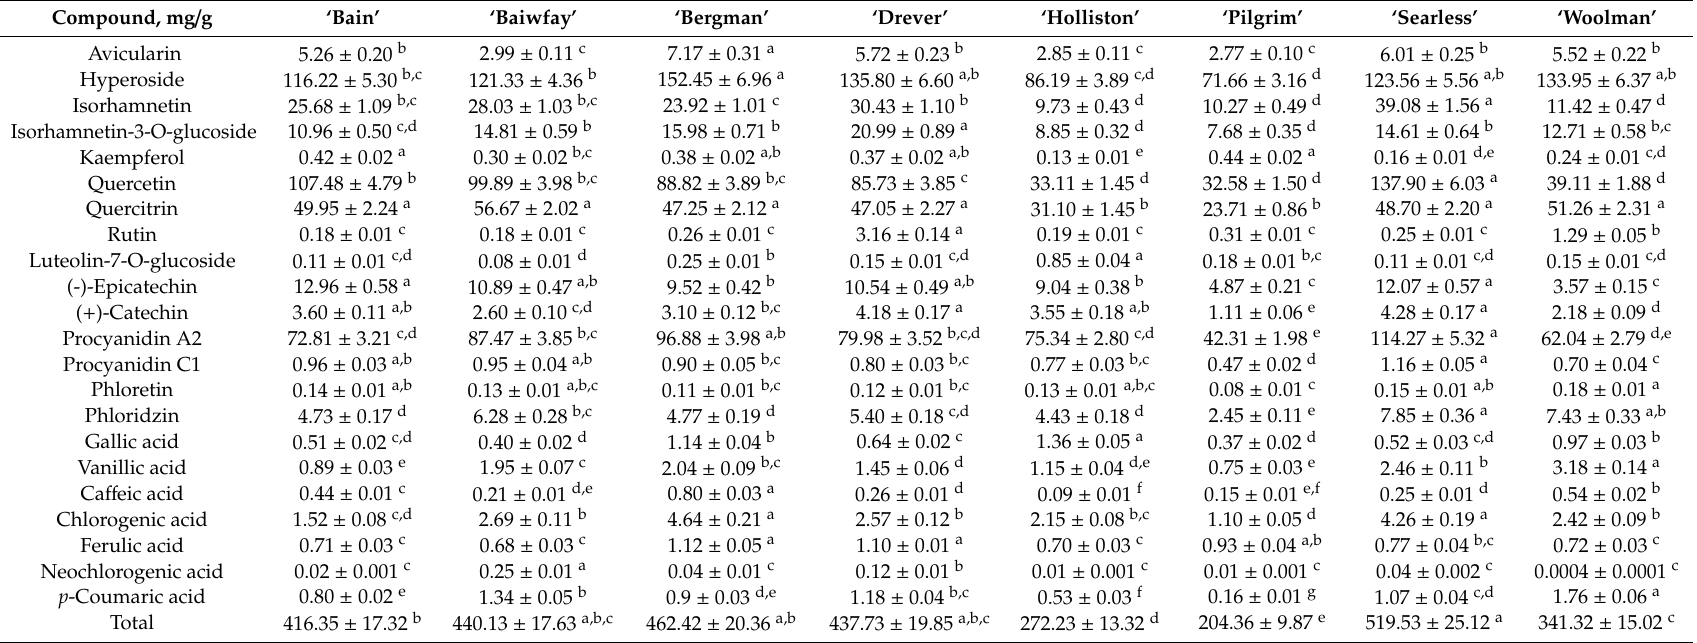
Table 1. Variability in the content of phenolic compounds in American cranberry fruit samples evaluated via the UPLC-ESI-MS / MS technique. The di ff erent letters indicate significant di ff erences between the